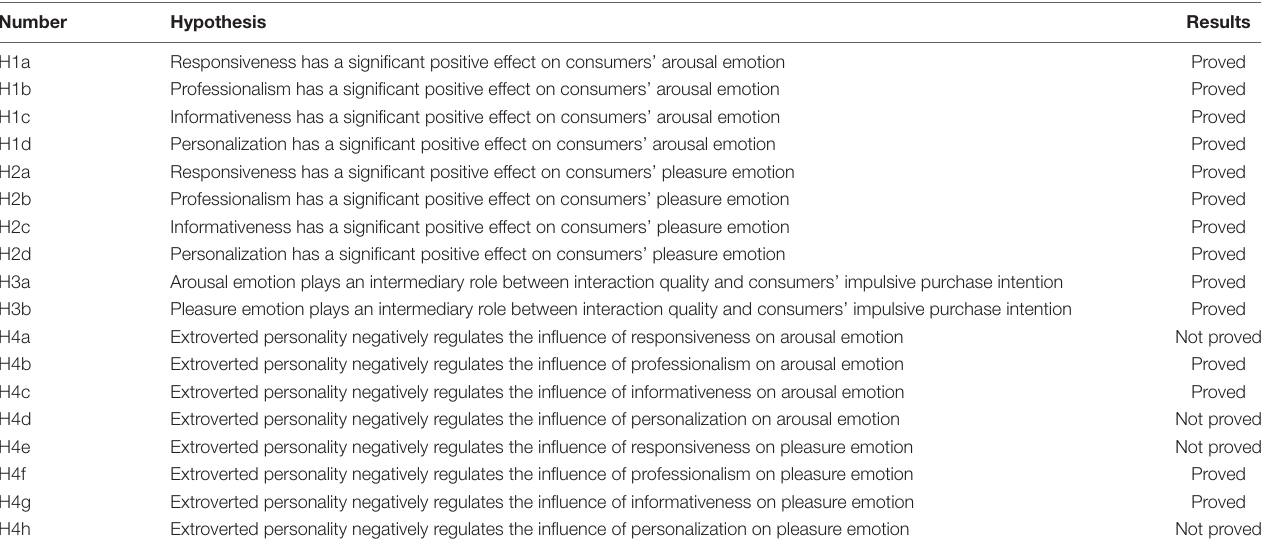
TABLE 6 | Summary of hypothesis test